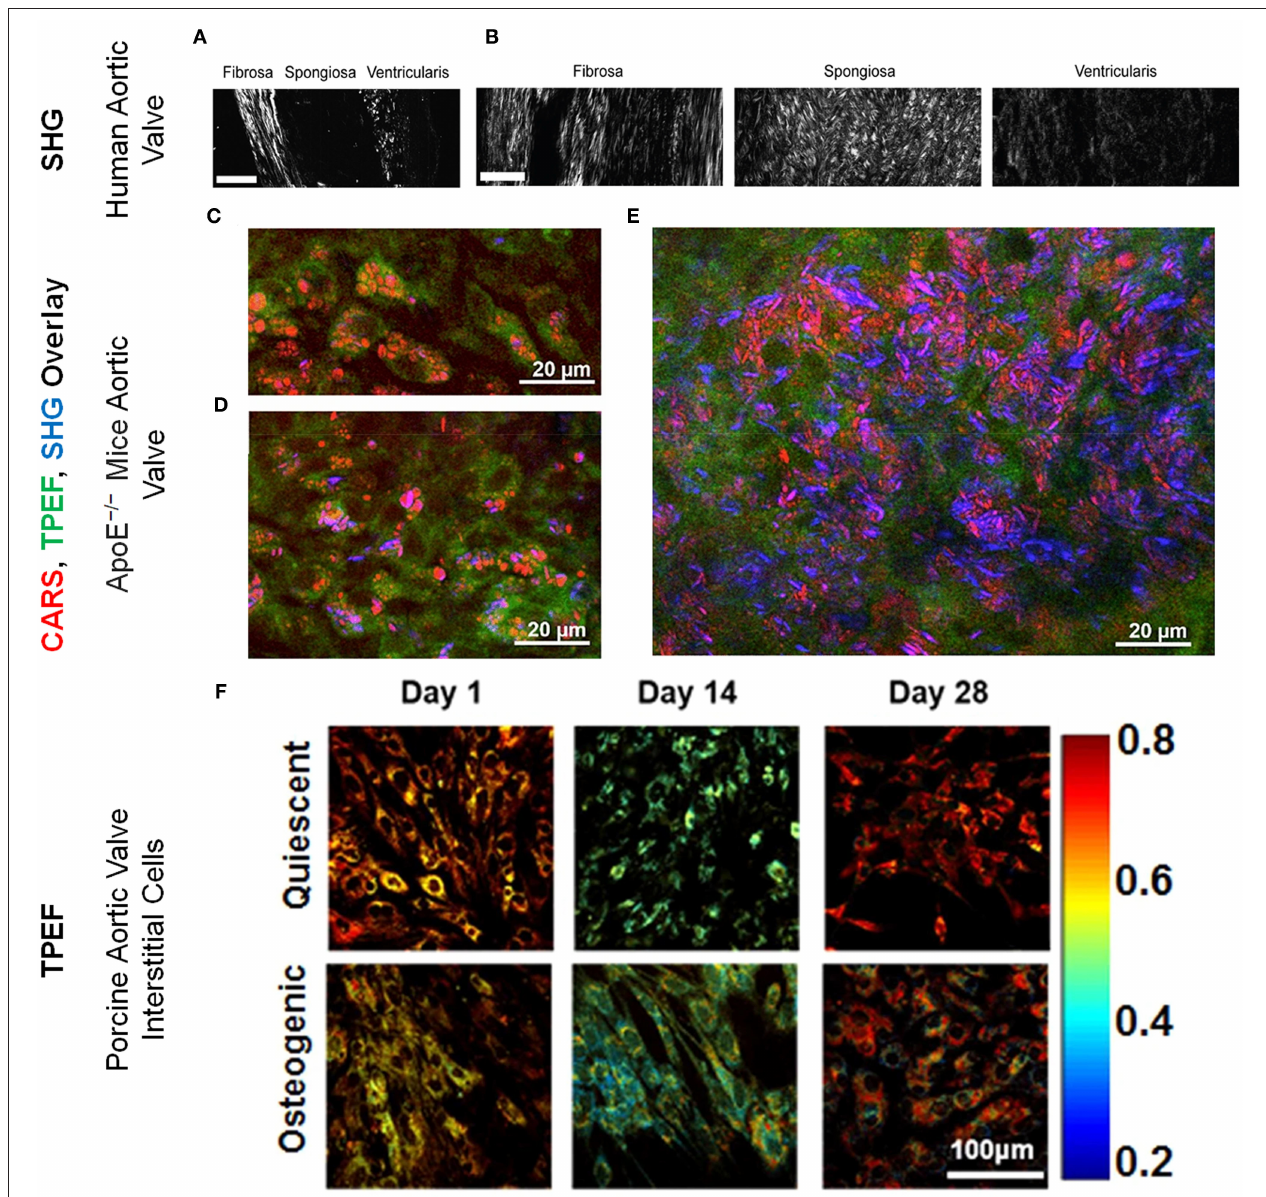
FIGURE 1 | Collagen microarchitecture in (A) healthy and (B) diseased aortic valve leaflets imaged via SHG imaging. Scale bar = 50 µ m. These figure panels were adapted from Hutson et al. (45) under an open access Creative Commons CC BY license. Aortic valve (acoronary) leaflet regions of ApoE − / − mice imaged via CARS (red; lipids and cholesterol), TPEF (green; cells) and SHG (blue; collagen) showing (C) lipid droplets and (D) cholesterol crystals within the cells and (E) lipid droplets and cholesterol crystals in the plaques. These figure panels were adapted from Jannasch et al. (66) under an open access Creative Commons CC BY license. (F) ORR maps for VICs cultured under quiescent and osteogenic conditions for 1, 14, and 28 days. ORR decreased in osteogenic VICs by 14 days. The color bar represents the value of unitless ORR ranging between 0.2 and 0.8. These figure panels were modified from Tandon et al. (43) under an open access Creative Commons CC BY